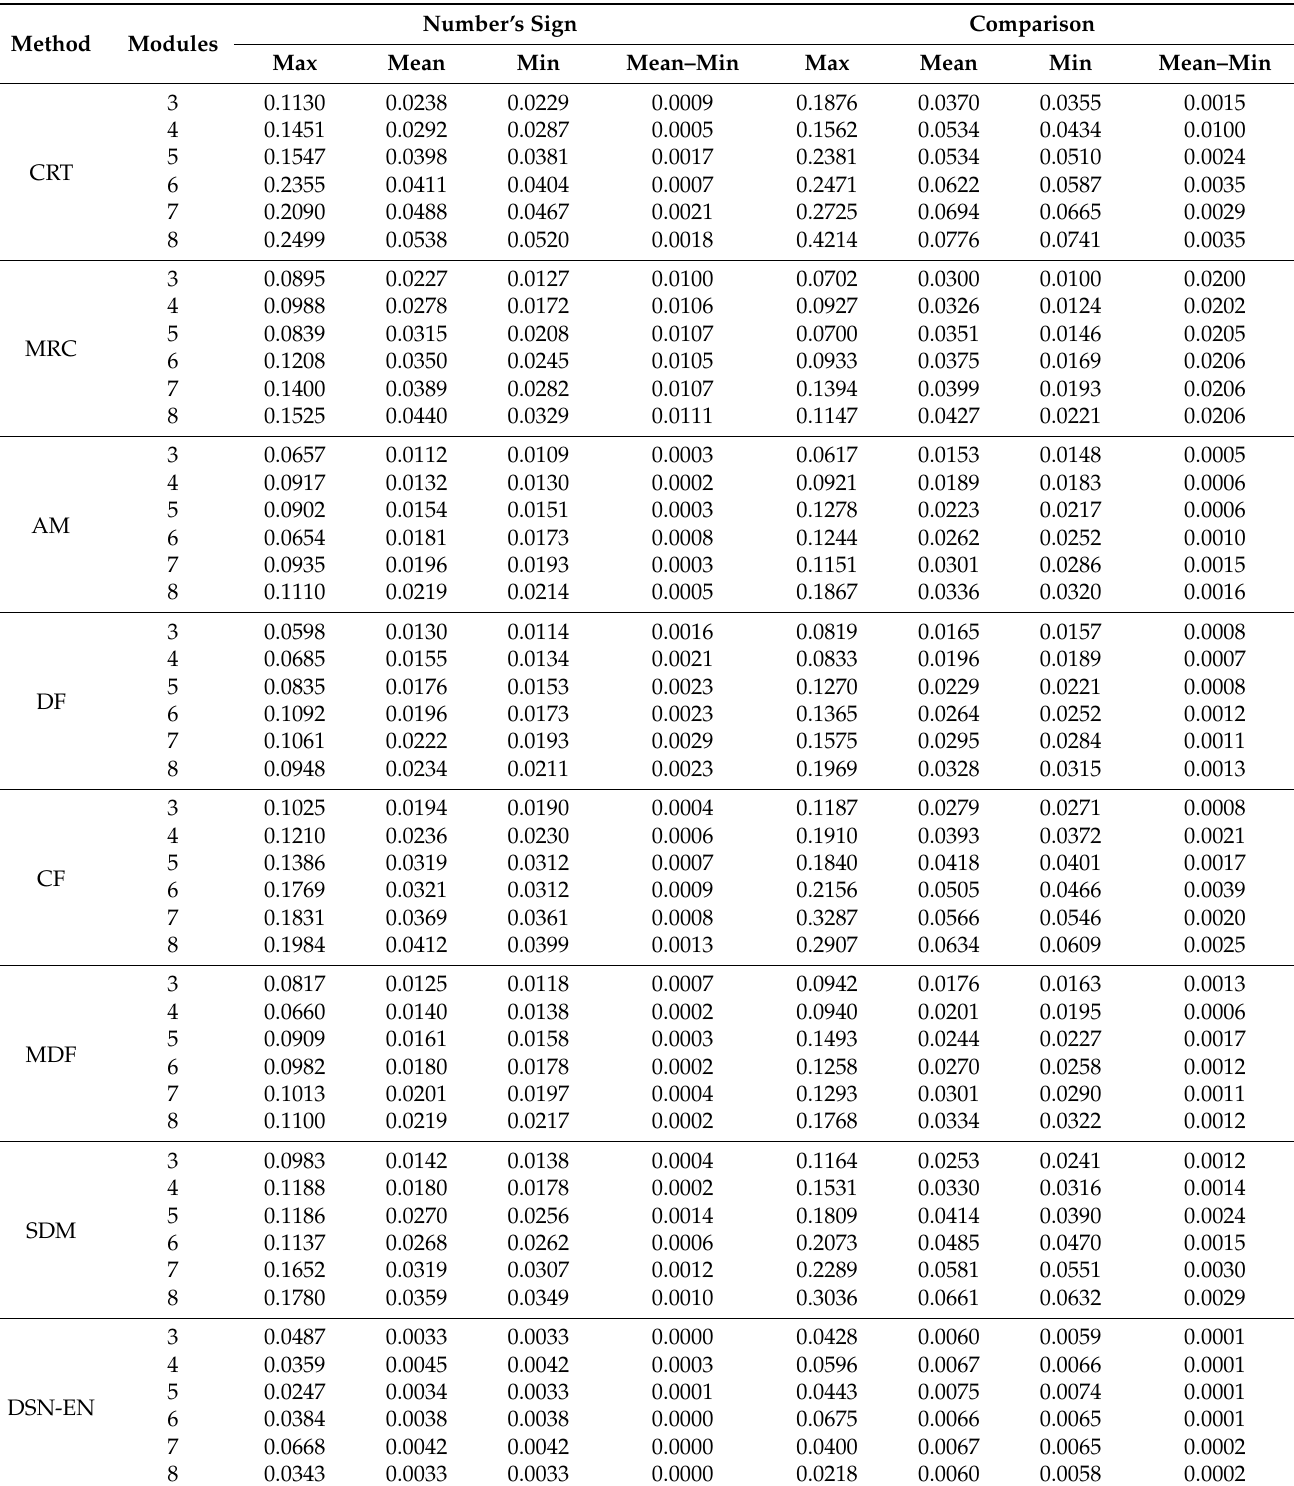
Table A1. Operation time with a dynamic number of modules p